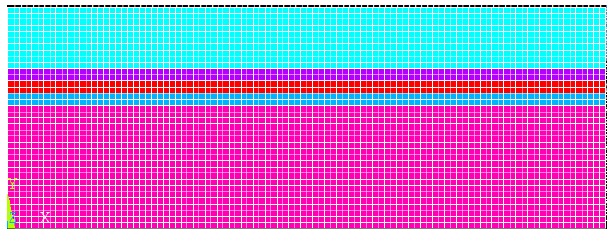
Figure 3. Finite element mesh of the specimen with the three-layer gradient.